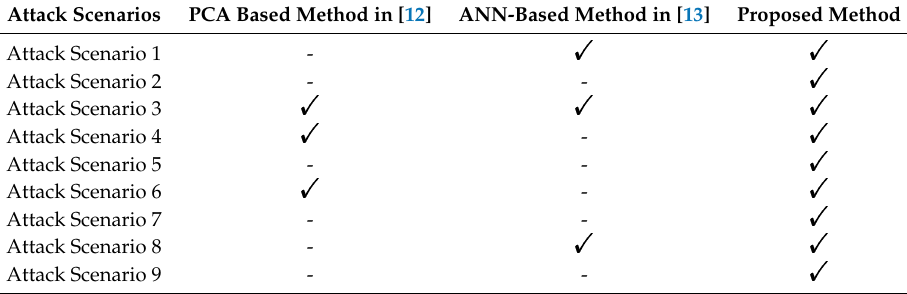
Table 3. Comparison of test scenarios in existing and proposed